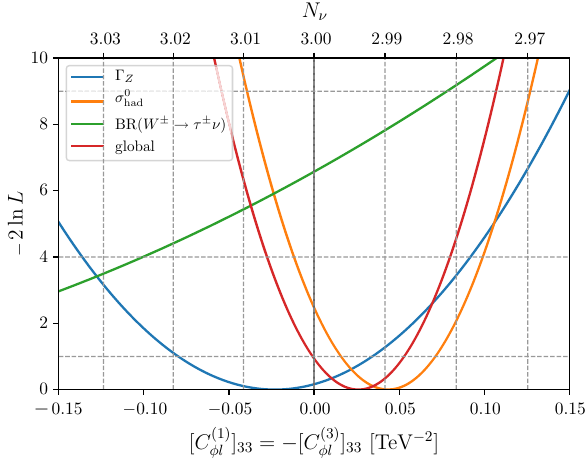
Fig. 8 Contributions to the log-likelihood ln L from the observables sensitive to a shift in the tau neutrino’s electroweak coupling and their combination, relative to their respective extrema. The axis on top shows the effective number of neutrino species that would correspond to the relative modification of the Z boson’s invisible